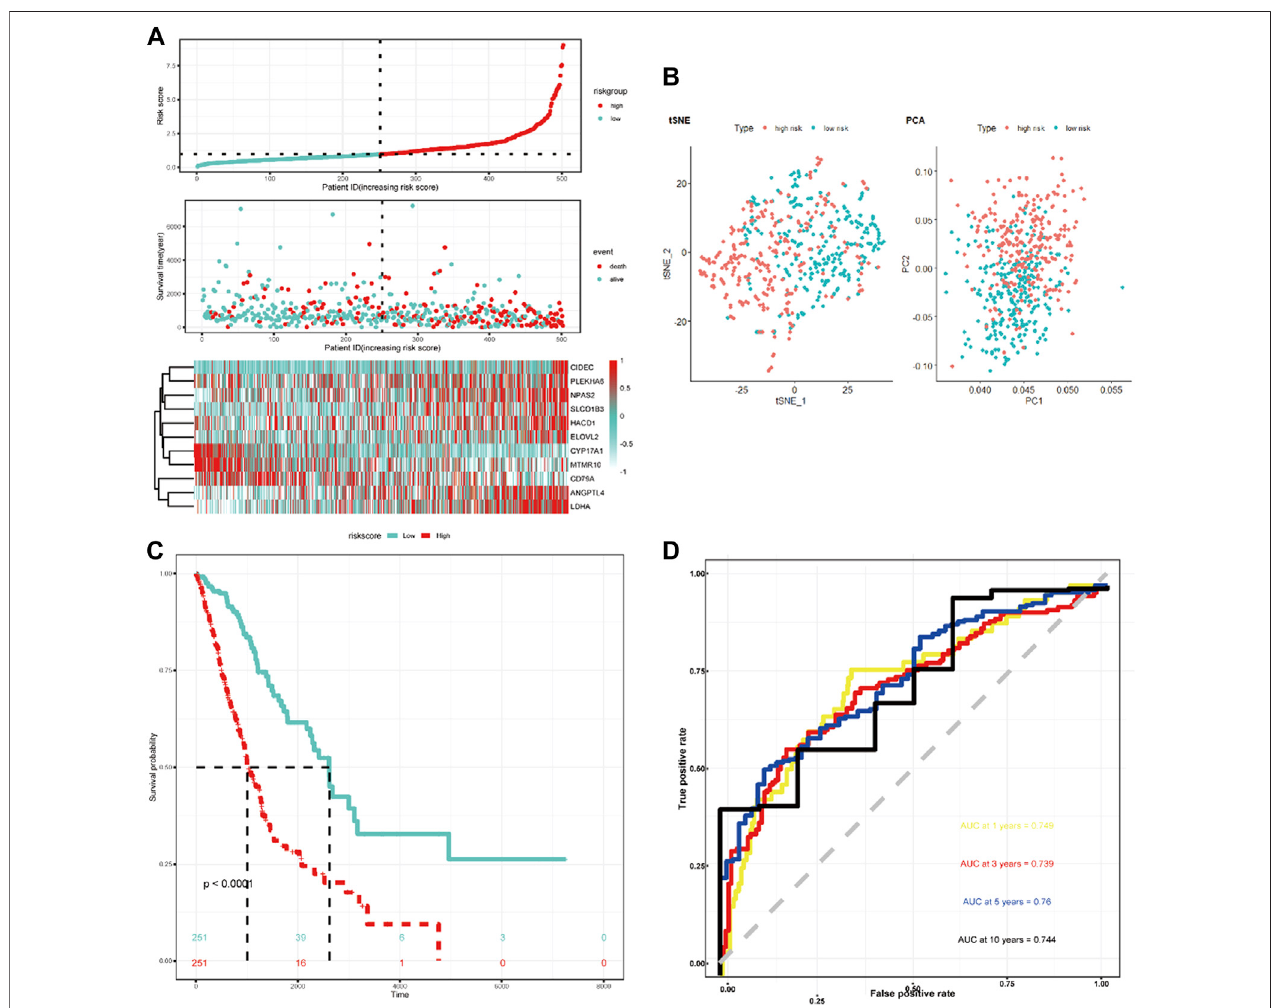
FIGURE 3 | Characteristics of the LRG-related prognostic gene signature. (A) Heatmap of the 11-LRG-related gene expression pro fi les and the distribution of risk scoreandsurvivaltime/statusforTCGA-LUAD. (B) t-SNEandPCAplotof11-LRG-relatedgeneexpressionpro fi les. (C) TheKaplan – Meiercurvewasplottedtoestimate the overall survival probabilities of the low- and high-risk groups. (D) The ROC curve was plotted to predict the 1-, 3-, 5-, and 10-year prognosis.